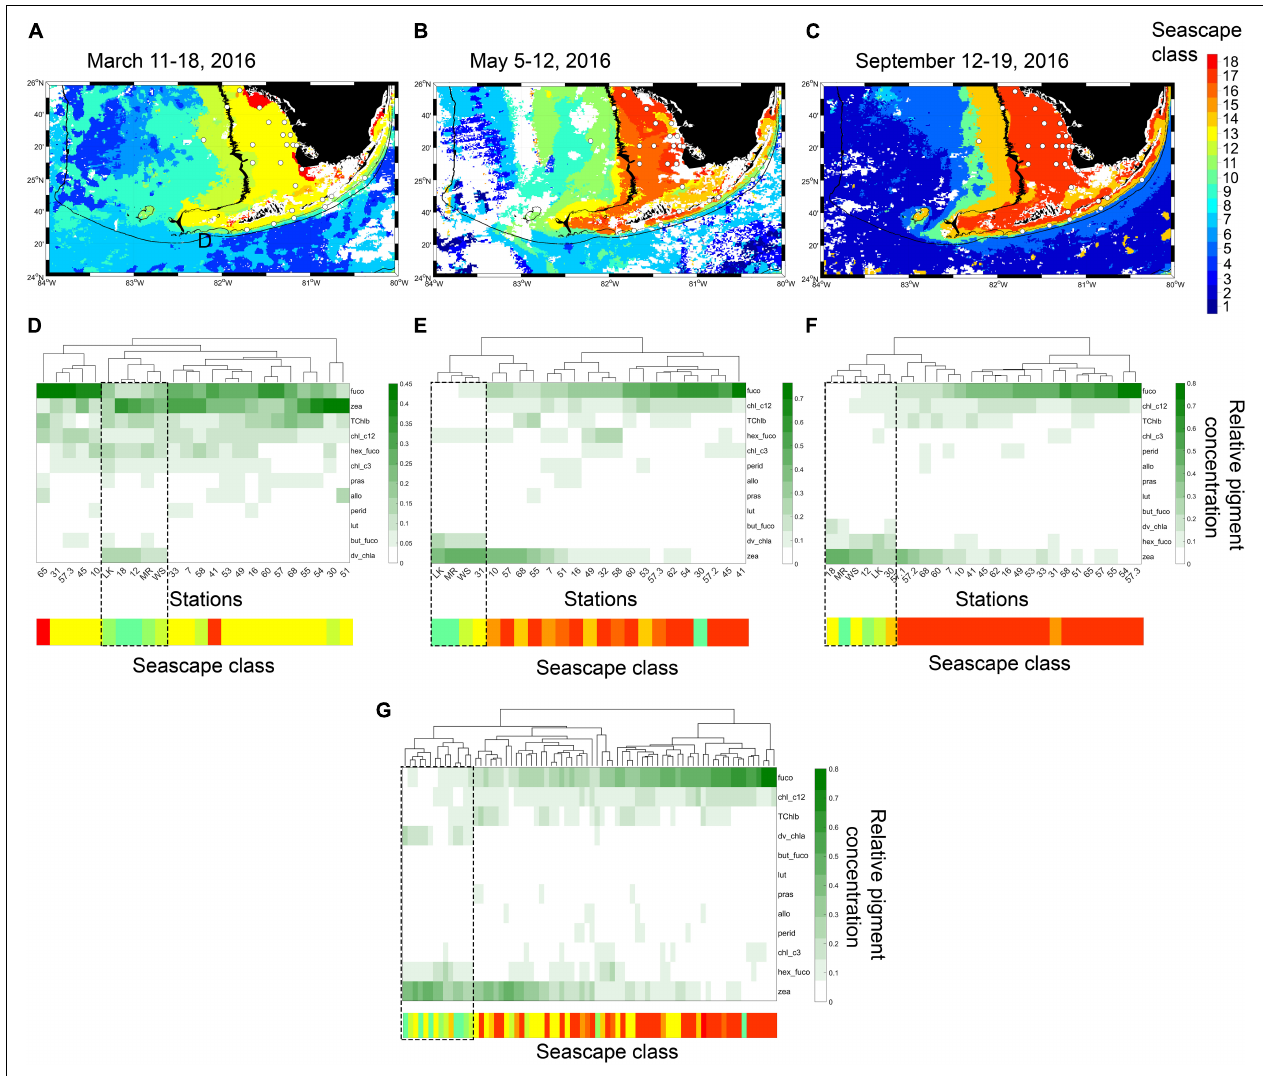
FIGURE 3 | (A–C) Eight-day composite seascape maps during each cruise with sampled stations shown with white dots. The 15 and 100 m isobaths are shown with black lines at 30 s spatial resolution. (D–F) dendrogram clustering of sampled stations derived from HAC analysis of pigment data (HPLC) for each sampling period. Heat maps below dendrograms show fractional proportions of specific diagnostic pigments relative to the sum of all diagnostic pigments at each site (note that color scale changes between sampling periods). Row labels in heat map are pigment abbreviations described in Supplementary Table S1 . Column labels in heat map correspond to station ID’s shown in Figure 1 . Color bars below heat maps indicate seascape class identified in each station during corresponding cruises. Dashed rectangles highlight clustering of stations where Mesotrophic and Transition seascapes (classes 10 through 12; Table 1 ) are dominant